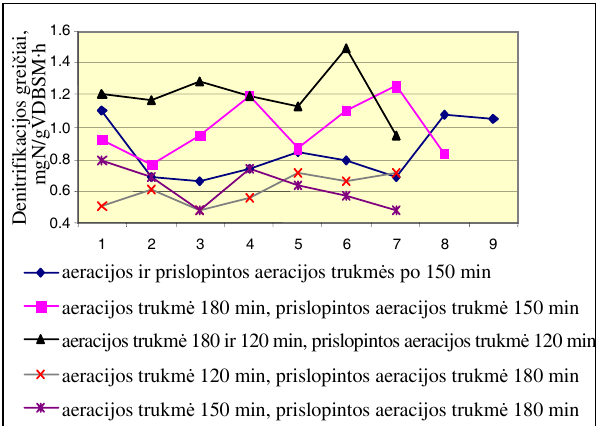
Fig 13. Nitrification rate change during five experiments